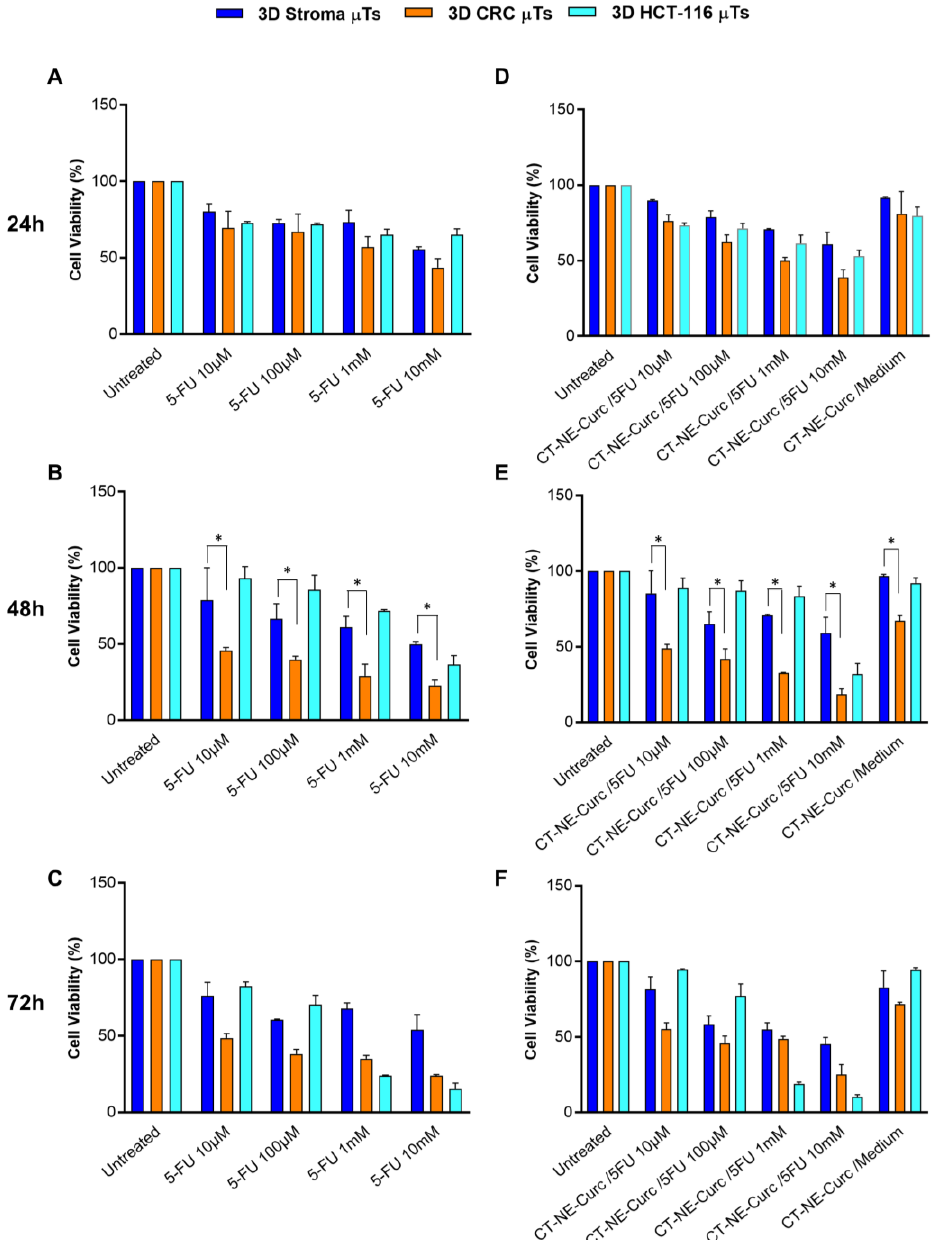
Figure 8. Cell viability assay for the 3D CRC μTs and 3D Stroma µTs treated with 5- Fluorouracil (5-FU) alone and in combination with Curcumin-loaded Nanoemulsions (CT-NE-Curc). ( A – C ) Graphs of the treatments with different concentrations of 5-FU at 24 h, 48 h, and 72 h; ( D – F ) graphs of the combination treatments with CT-NE-Curc and different concentrations of 5-FU at 24 h, 48 h, and 72 h. All the experiments were performed in triplicate (n = 3); the values represent the mean and mean standard error ( ∗ p < 0.05).